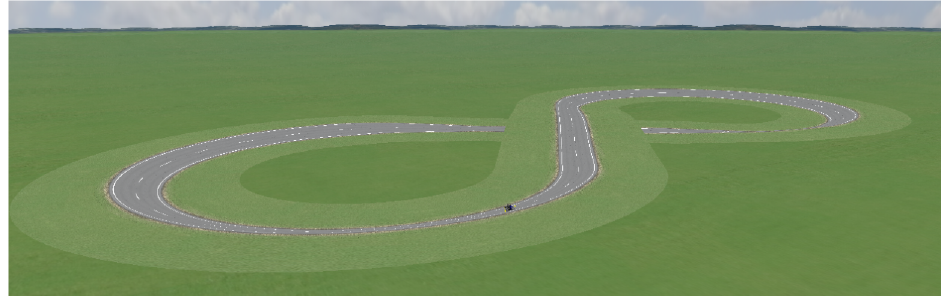
Figure 13. Designed Road.